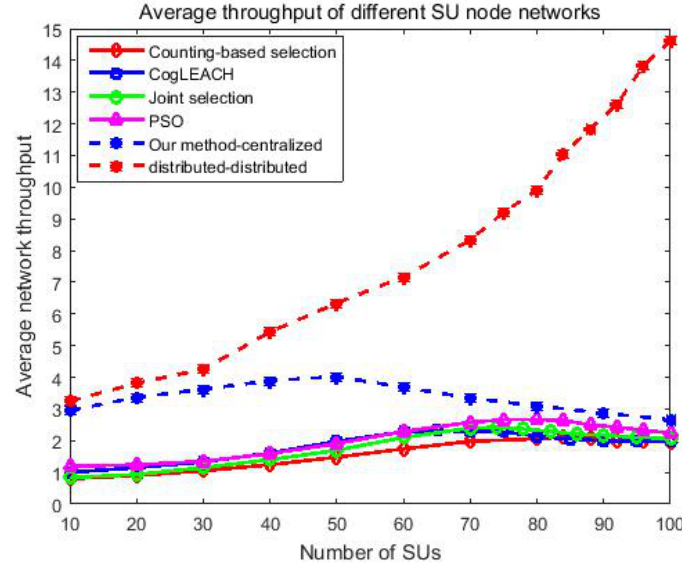
Figure 11. Average throughput of different SU node networks.